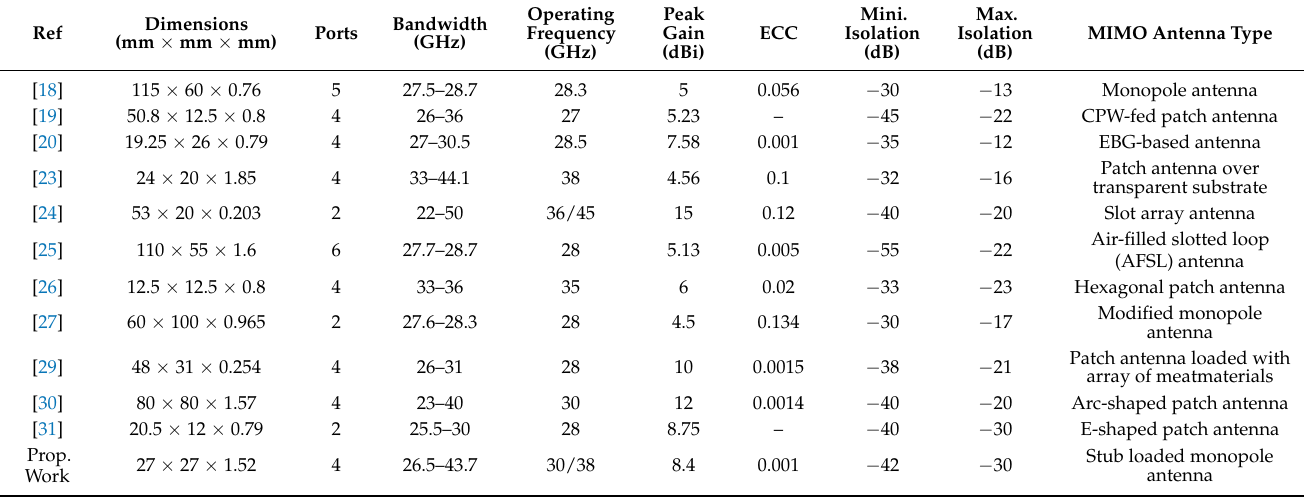
Table 1. Comparison between suggested and literature works operating over same